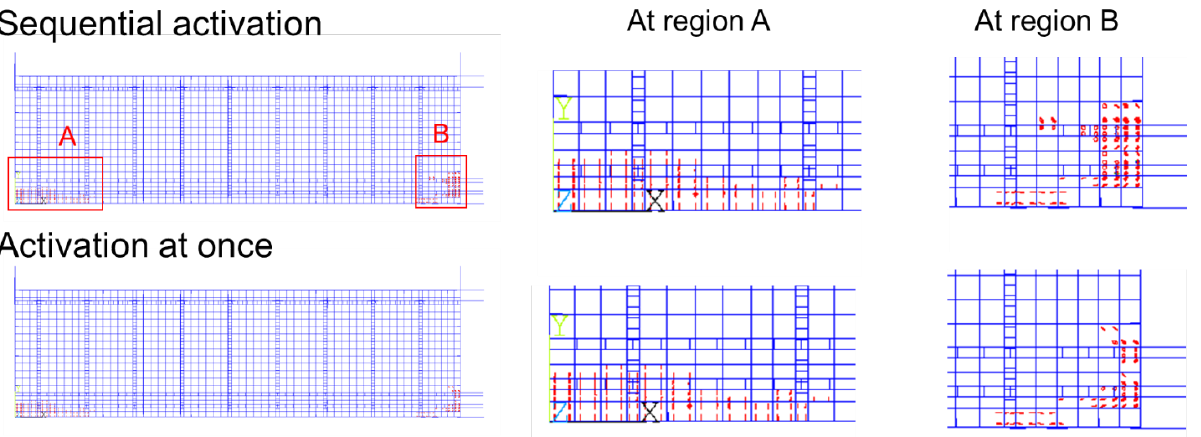
Figure 9. Concrete cracking patterns on x - y plane developed during activation of 5 Fe-SMA bars, with sequential activation and with activation at once. with sequential activation and with activation at